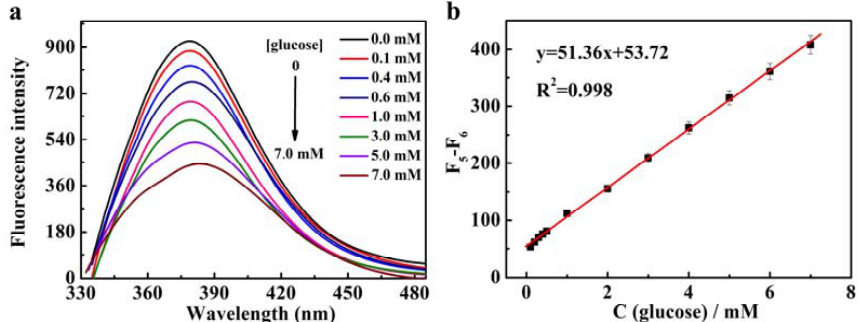
Figure 6. Fluorescence spectra of CNDs in the presence of different concentrations of glucose ( a ) and the corresponding linear range ( b ). The concentrations of CNDs, Cu 2+ and GOx were 0.014 mg/mL, 600 nM, and 10 U/mL, respectively. Table 2. Comparison of analysis methods for the detection of glucose.